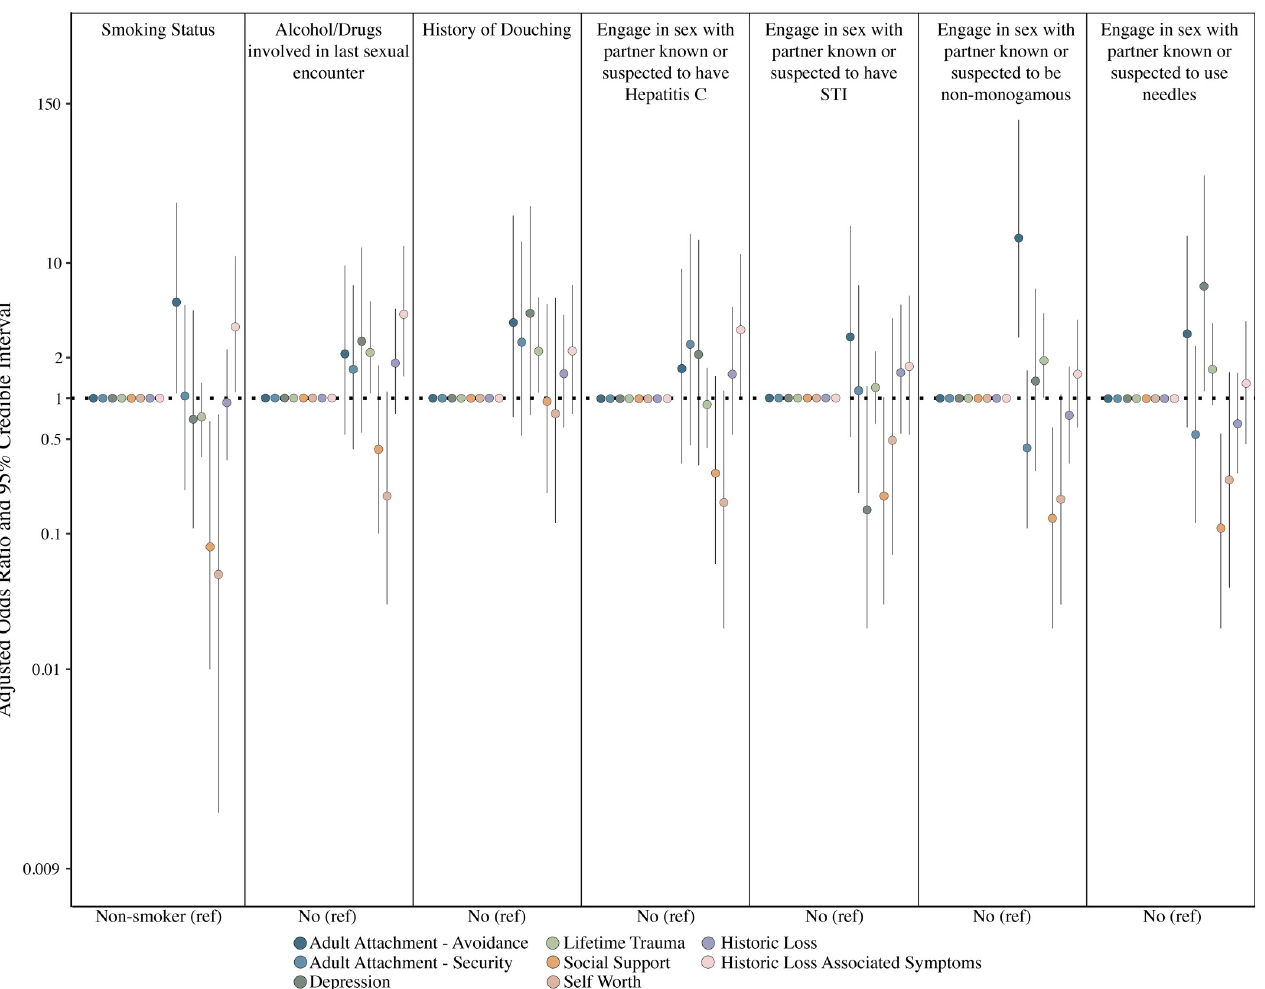
Fig 4. Adjusted odds ratio for sexual and lifestyle practices by measures of psychosocial stress. Circles represent point estimates while bars indicate 95% credible intervals.